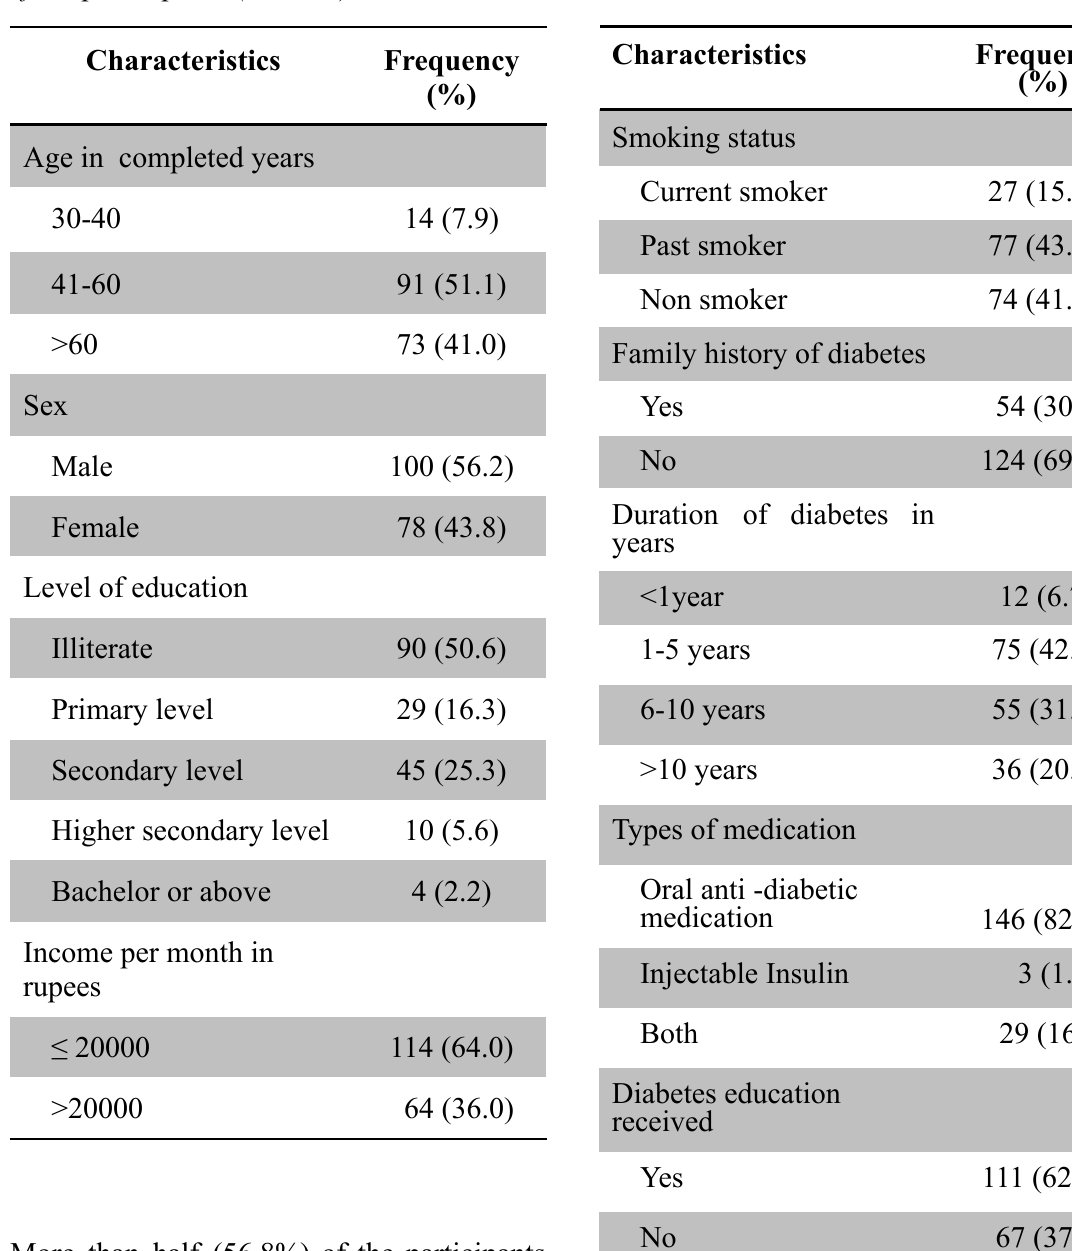
Table 1: Socio-demographic characteristics of the participants (n = 178)